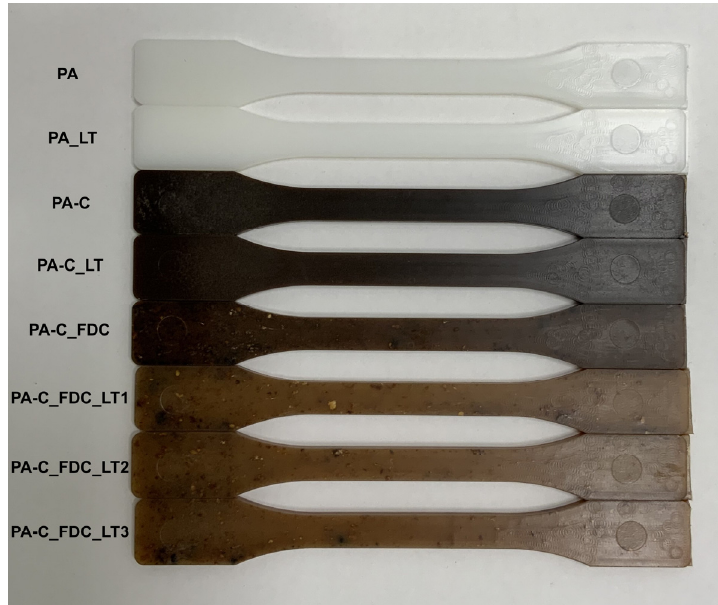
Figure 3. Macroscopic overview of the samples.